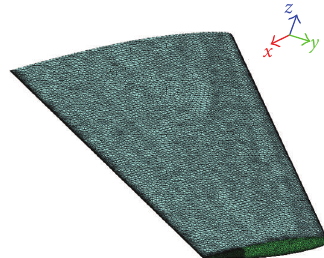
Figure 24: Initial ONERA M6 wing mesh.